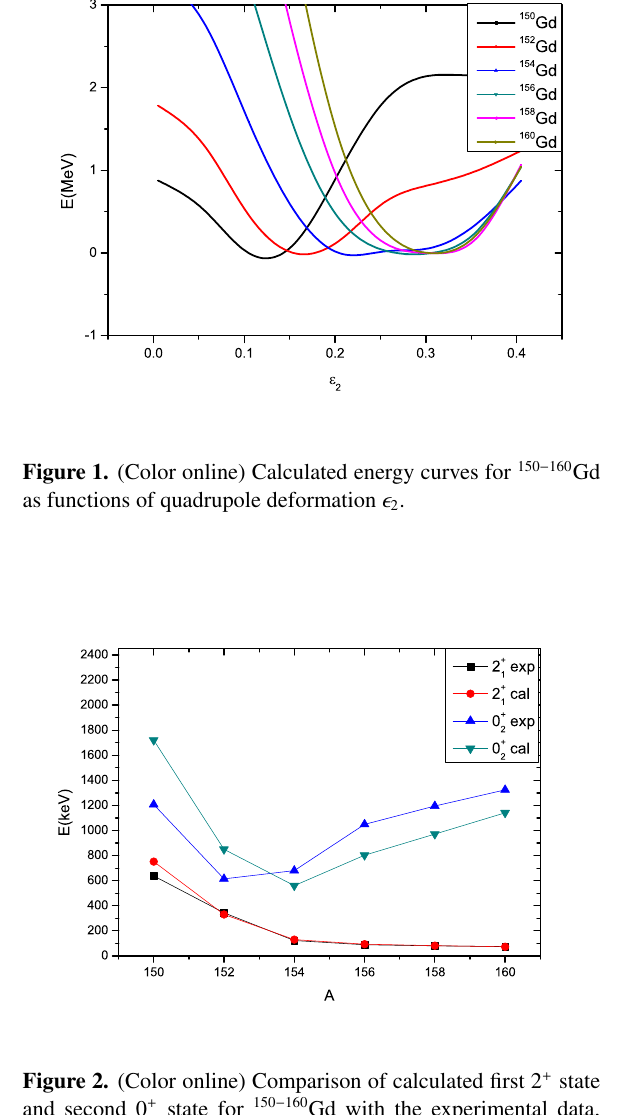
Figure 3. (Color online) Comparison of calculated B ( E 2) values from the first 2 + state to the ground state for 150 − 160 Gd with the experimental data, taken from